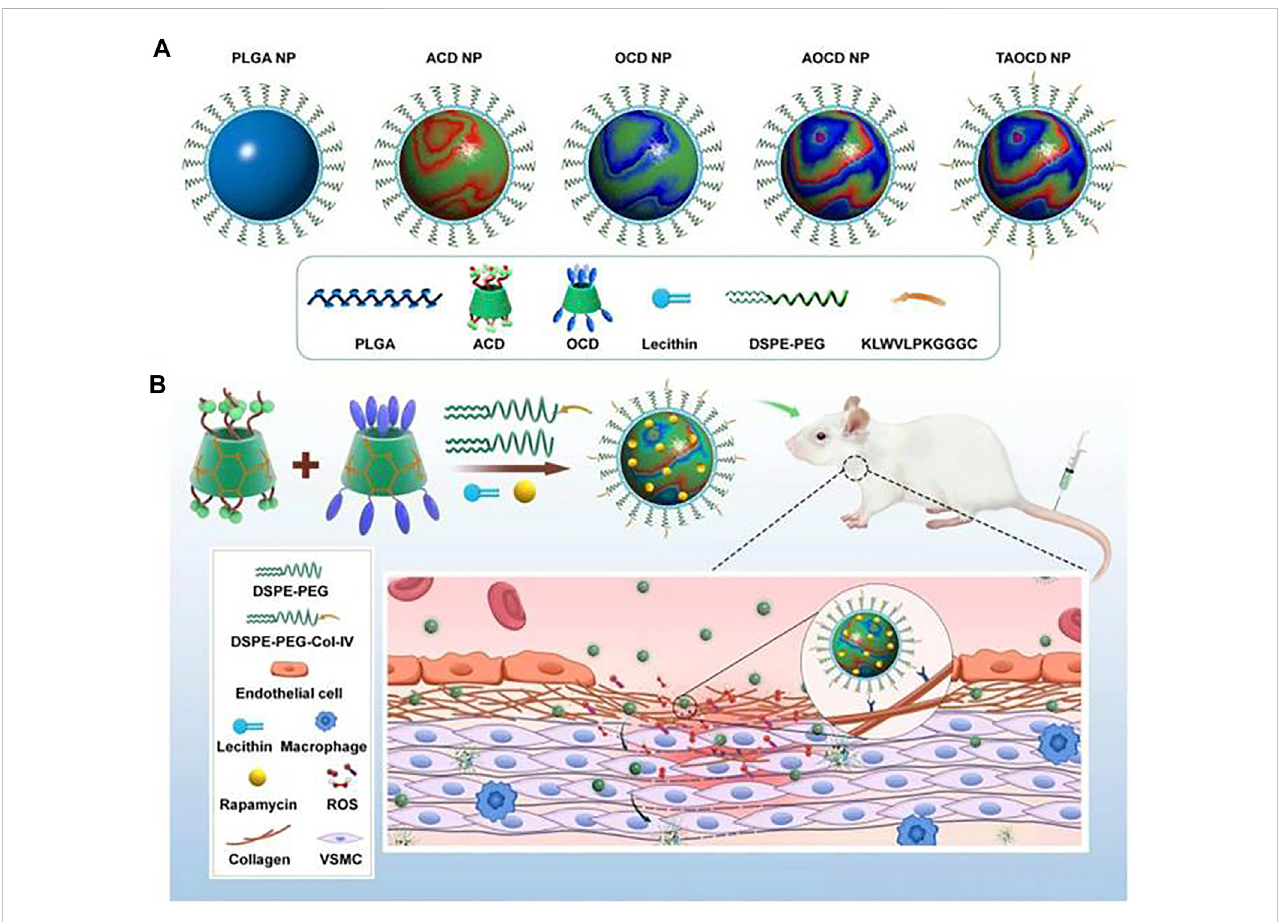
FIGURE 2 A pH/ROS dual-responsive nanotherapies based on a pH-sensitive ß -CD material (ACD) and a ROS-responsive ß -CD material (OCD) for targeted treatment of restenosis. (A) Schematic illustration of different NPs. (B) The targeted treatment of a dual-responsive, targeting rapamycin nanotherapy. Reproduced from Zhang et al. (2018), with permission from Elsevier